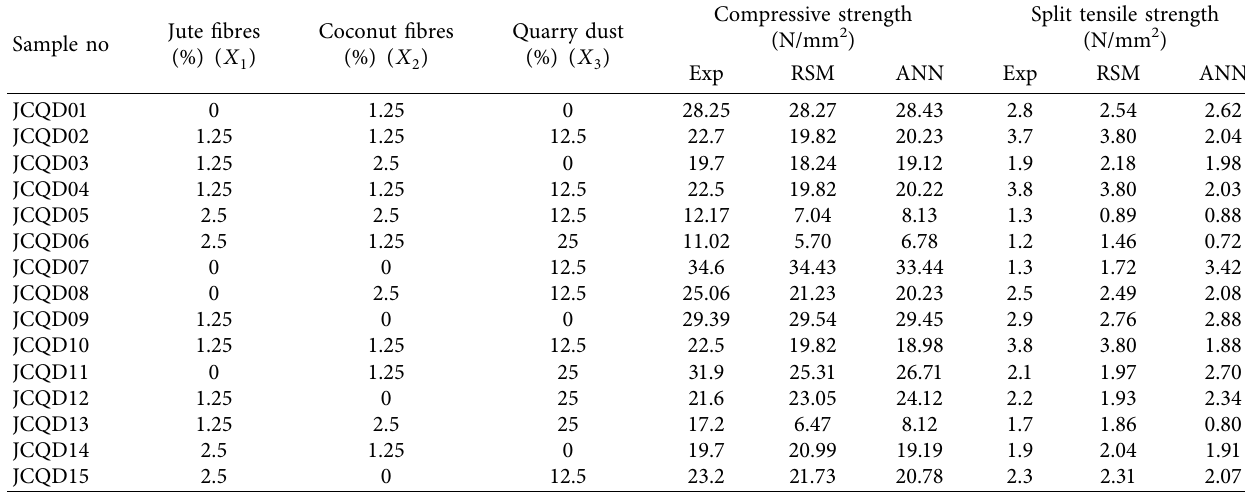
Table 5: Predicted strength values of concrete using RSM &ANN.